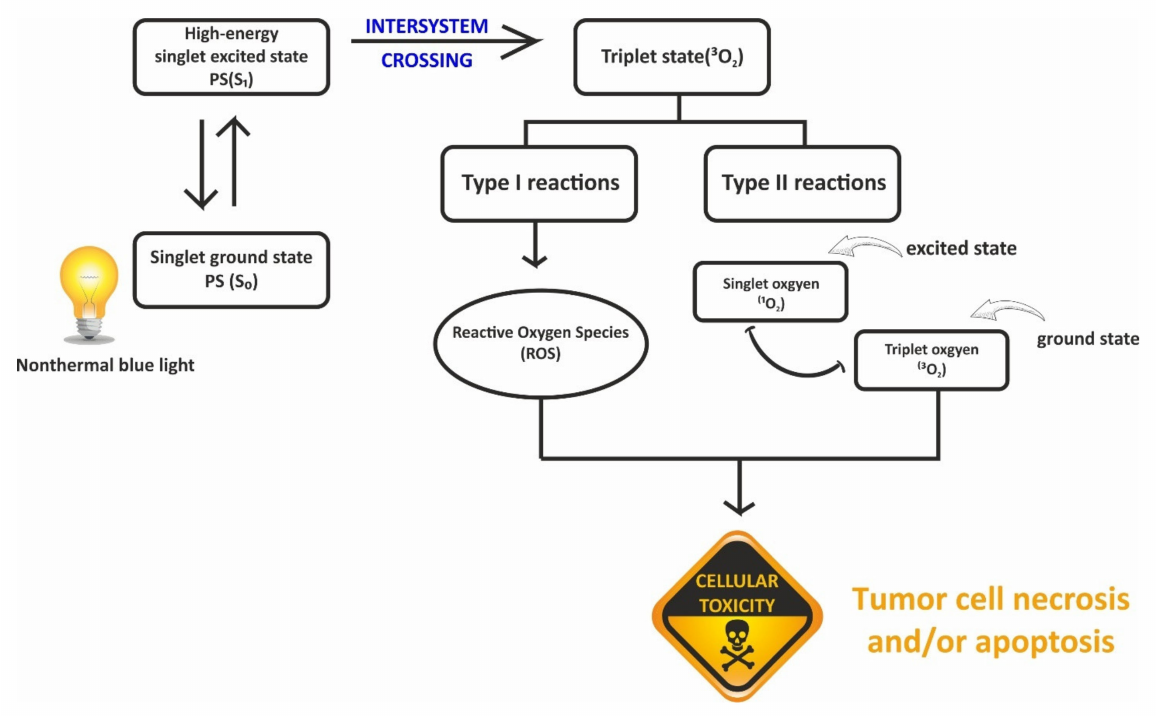
Figure 9. Type I and Type II reactions in PDT (photodynamic